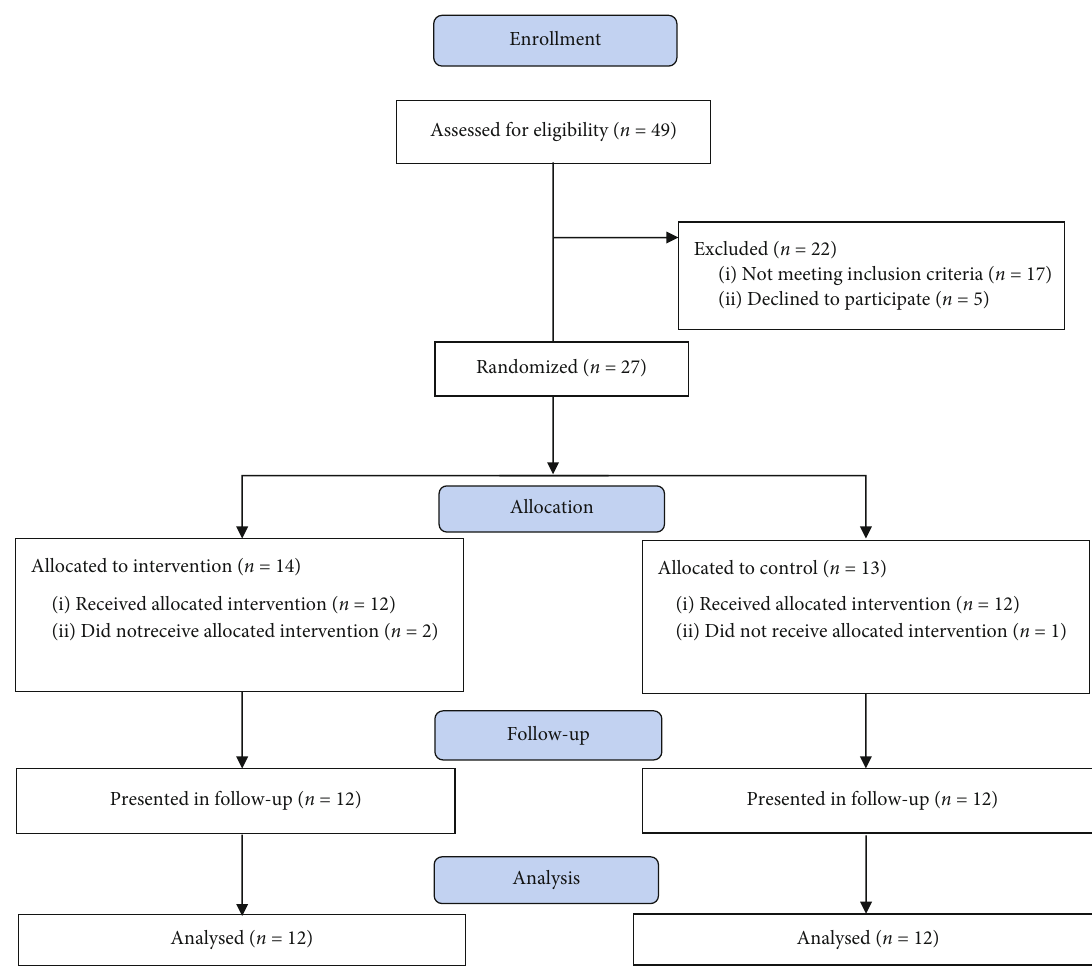
Figure 1: Flowchart of the participants included in the